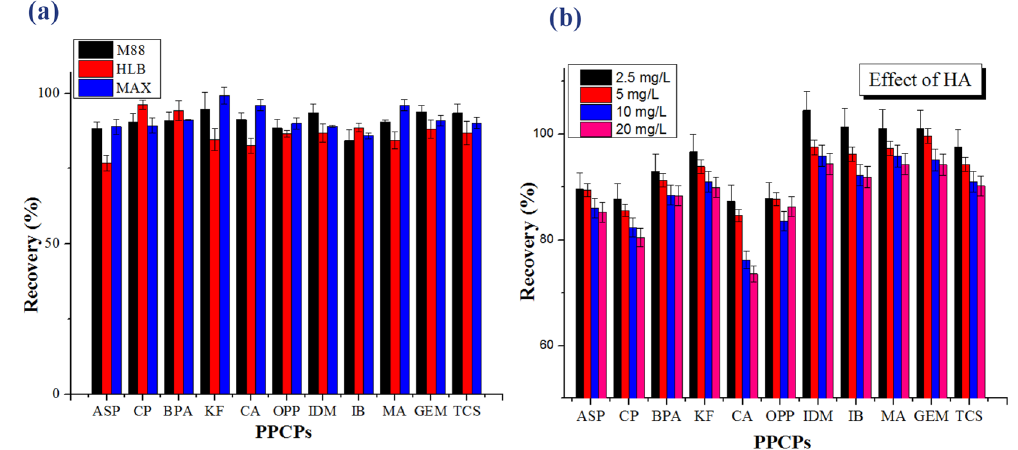
Figure 7. ( a ) Comparison of M88 performance with commercial extraction materials. ( b ) Effects of HA on the recovery of PPCPs by